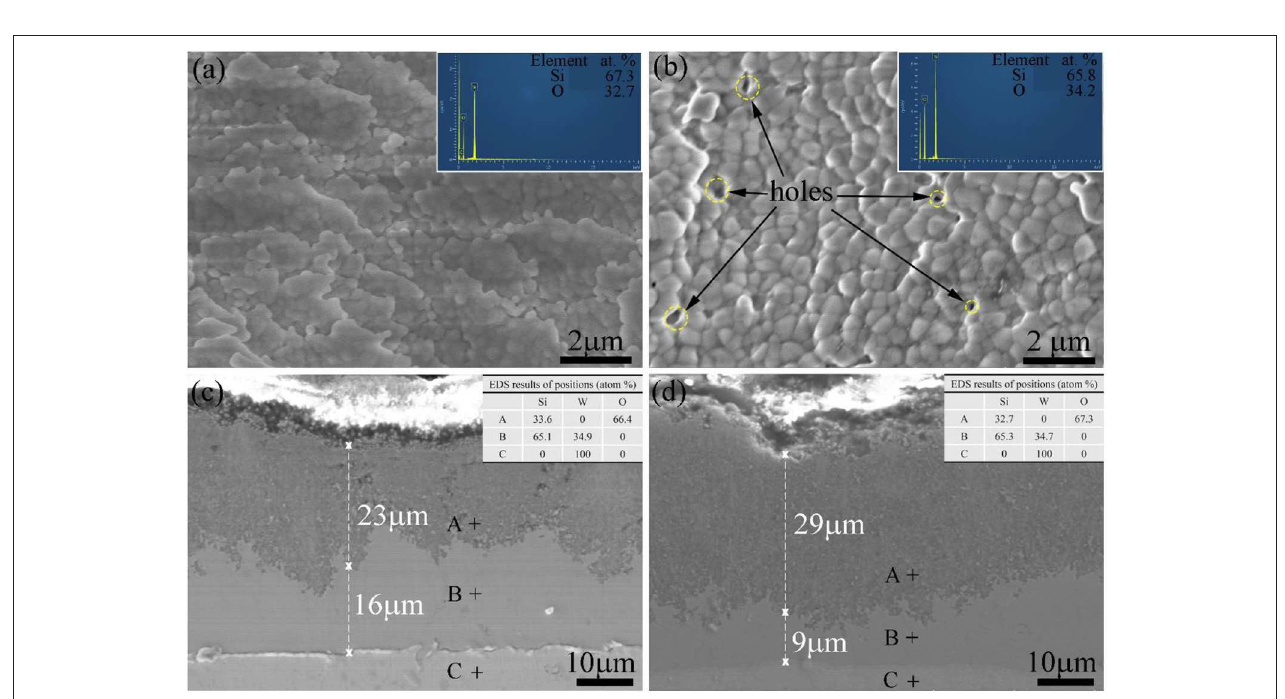
FIGURE 13 | Surface (a,b) and cross-sectional (c,d) SEM images of the sample S4 after oxidation at 1,000 ◦ C for 10h (a,c) and 15h (b,d) .